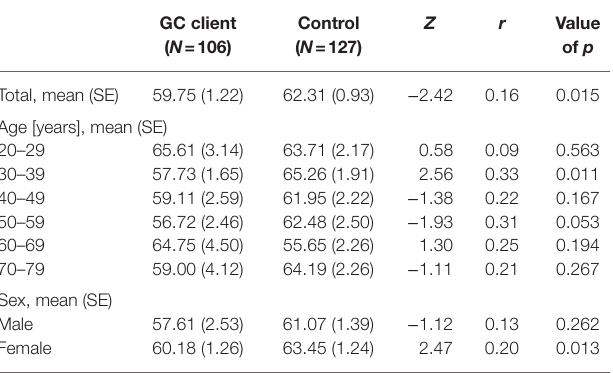
TABLE 6 | Comparison of the total MCQJ-30 score by age group and sex using the Wilcoxon rank sum test. GC client ( N = 106)